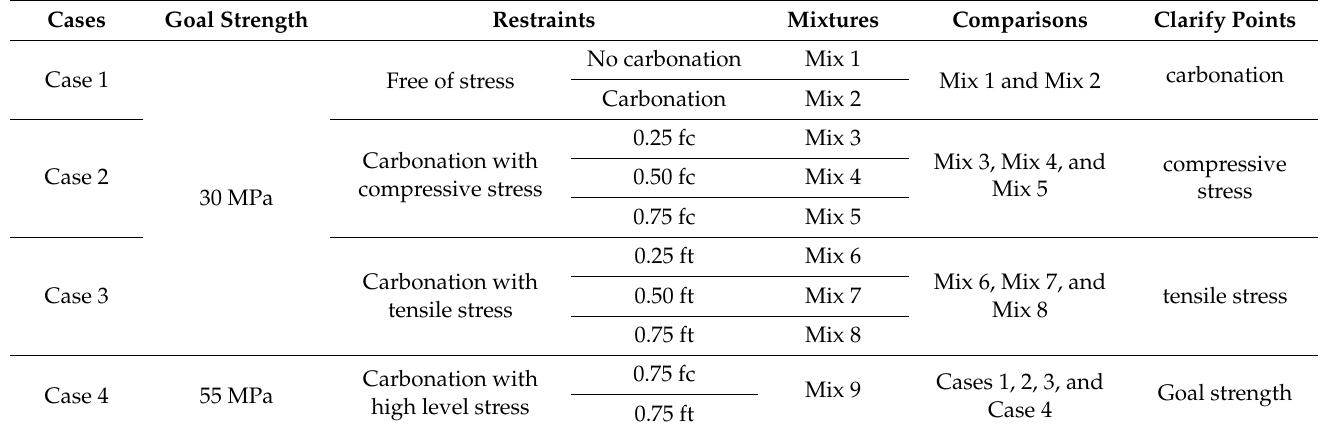
Table 4. Summary of case